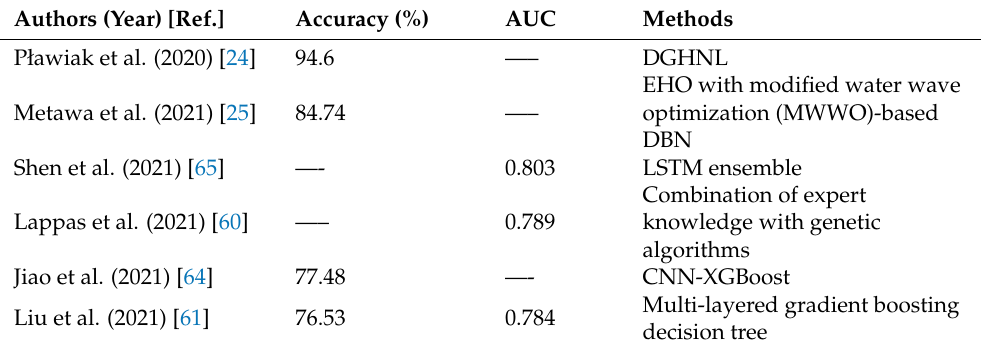
Table 13. Performance of deep-learning-based classifiers on the German (numerical) dataset. Authors (Year) [Ref.]